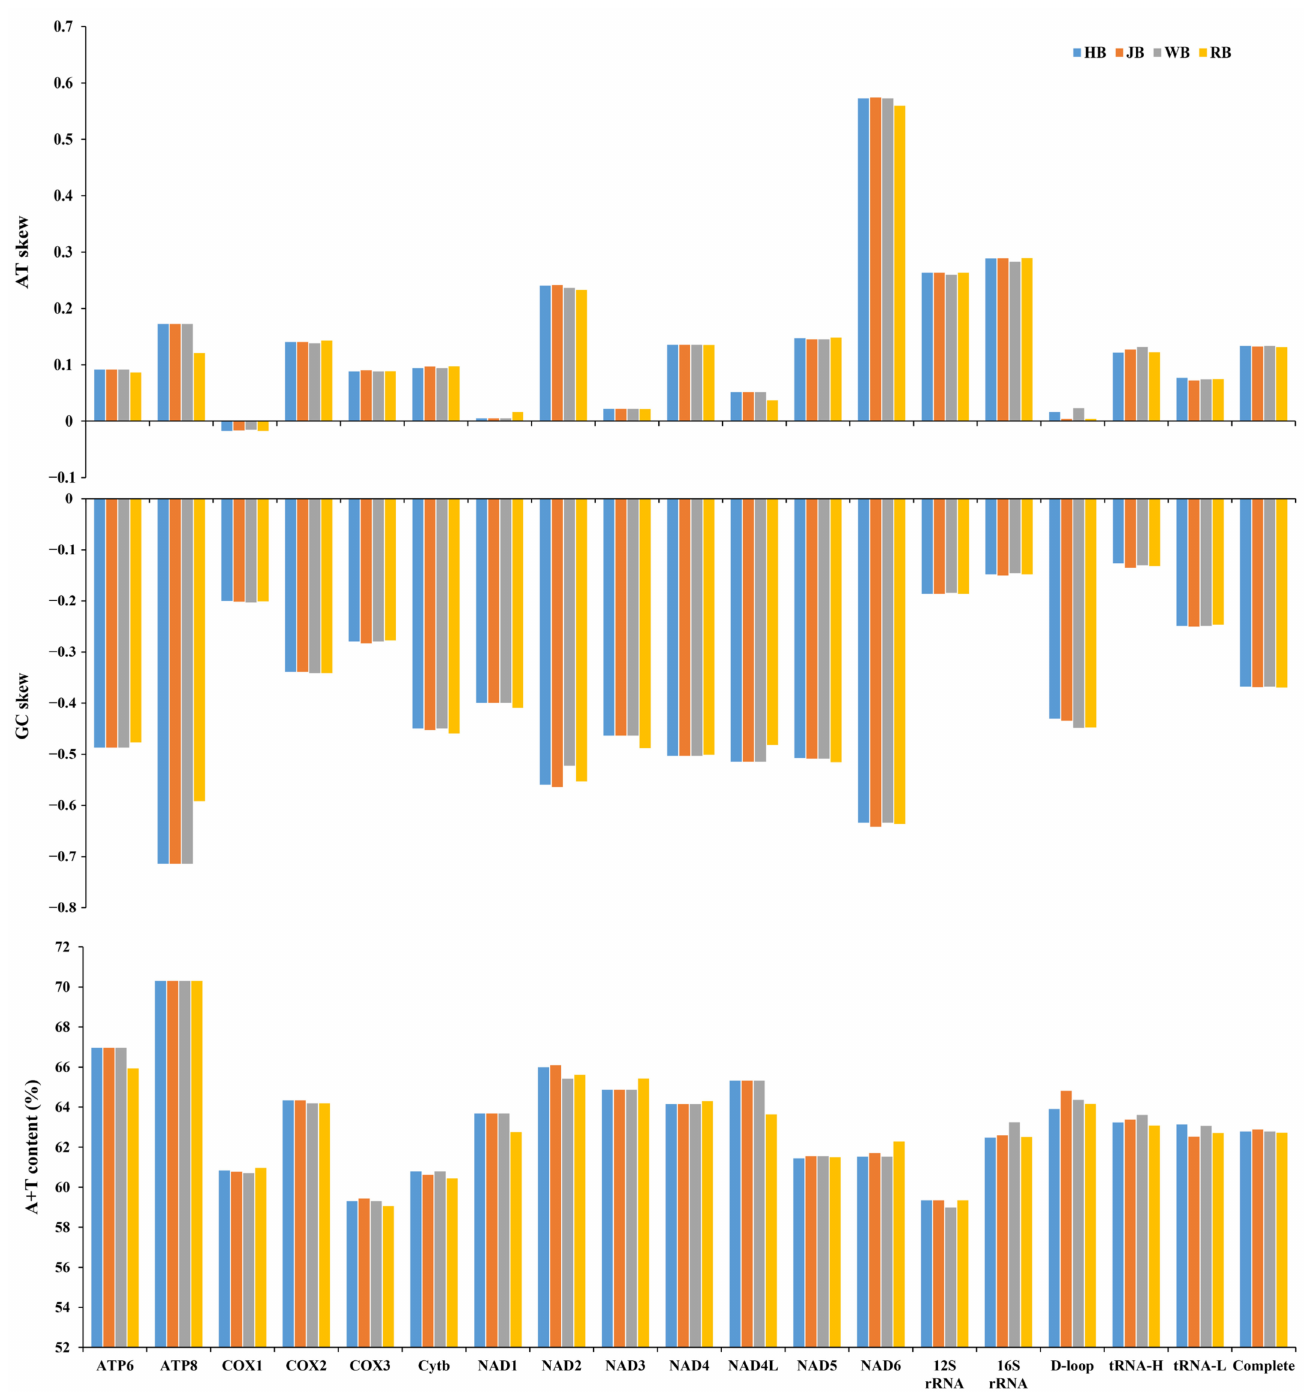
Figure 2. Nucleotide compositions of mitochondrial genome elements of four P. sinensis strains